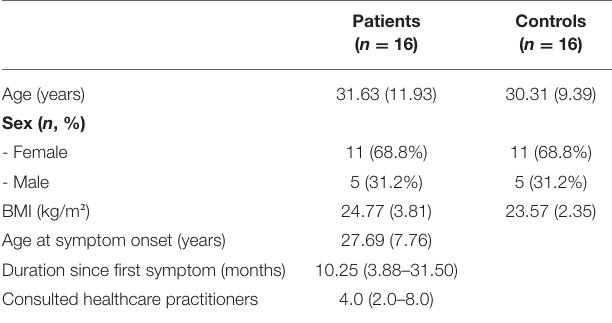
TABLE 1 | Demographic and clinical characteristics of patients and controls [data presented as n (%), mean (SD), or median (1st quartile − 3rd quartile)].